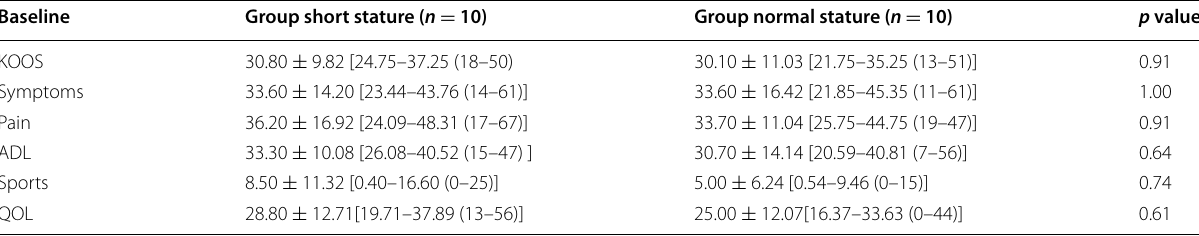
Table 3 Preoperative Knee Injury and Osteoarthritis Outcome Score (KOOS) and subtypes in patients of short versus normal stature scheduled for total knee arthroplasty